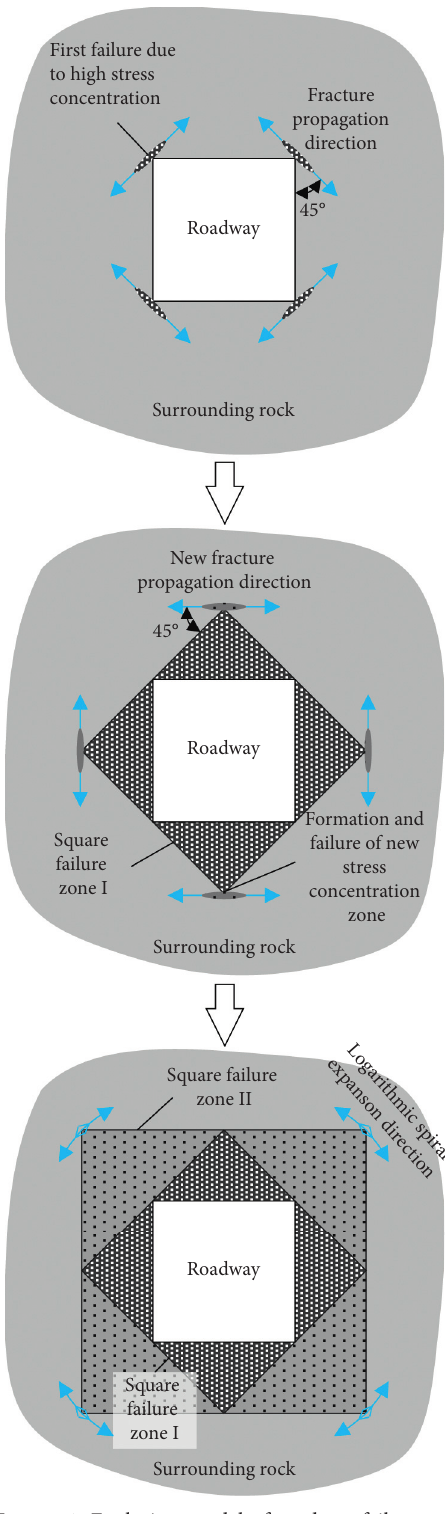
Figure 1: Evolution model of roadway failure original rock stress along the X -axis direction, λ is the stress ratio along Y -axis to the x -axis, and θ is the polar angle.